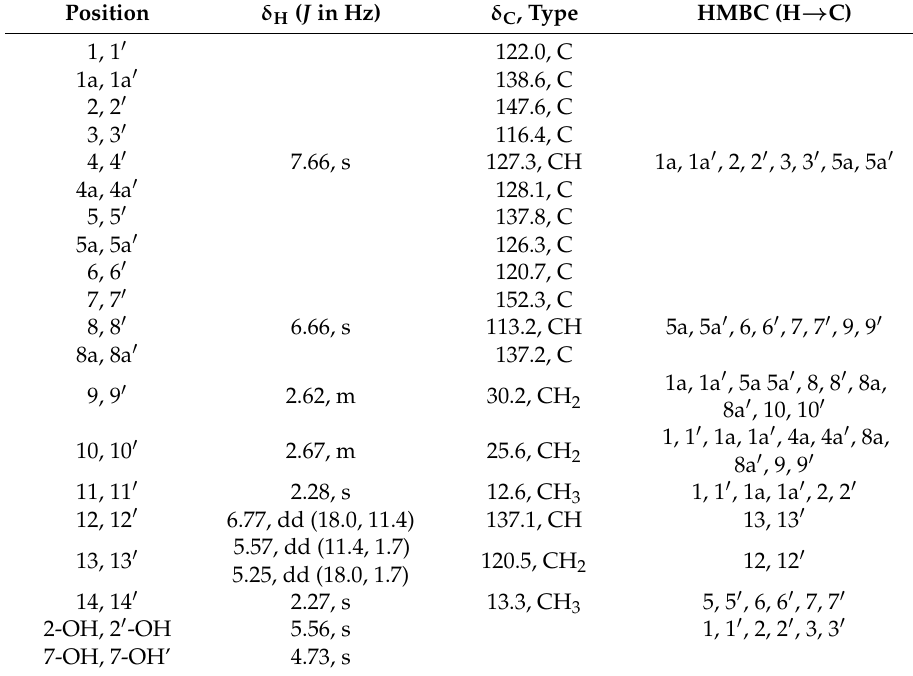
Table 2. NMR spectroscopic data for compressin B (Compound 2 ) (500 MHz ( 1 H), 125 MHz ( 13 C), δ in ppm, CDCl 3 ).